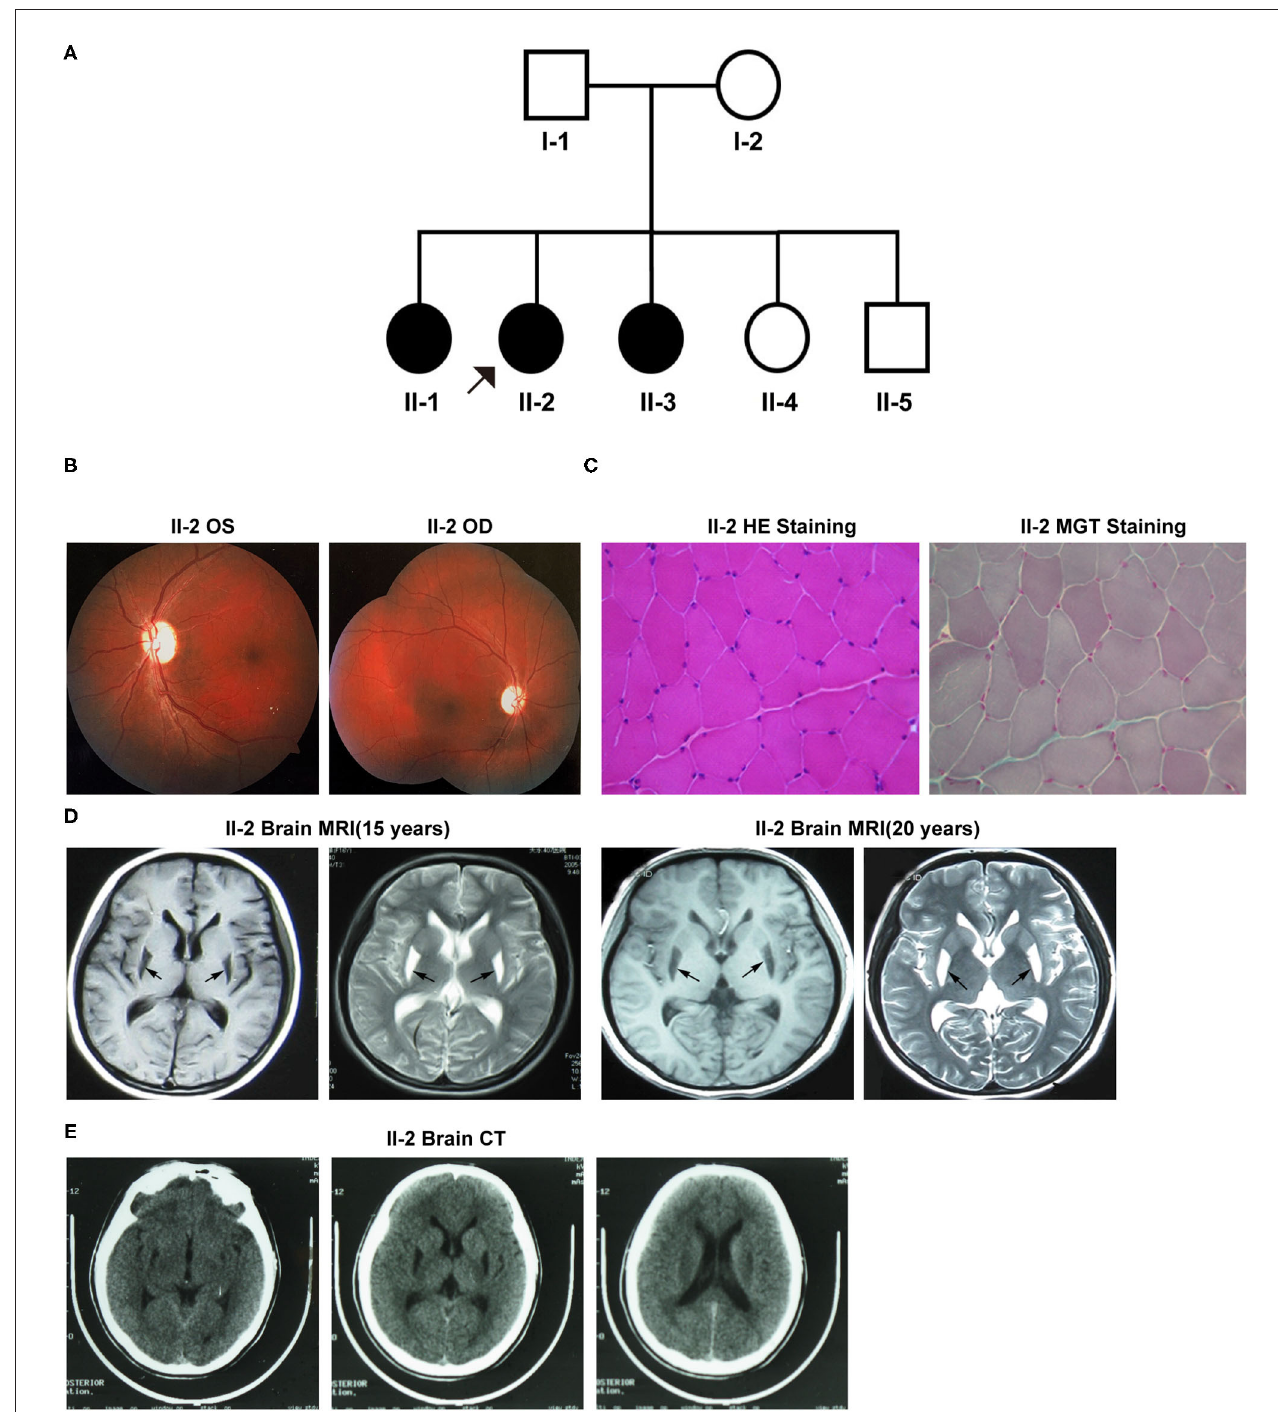
FIGURE 1 | (A) The pedigree diagram of the family included in this study. (B–E) Clinical manifestations of the proband (II-2). (B) Fundus fluorescein angiography. (C) Muscle biopsy with specific staining. (D) Brain MRI at 15 and 20 years old. (E) Brain CT. OS, oculus sinister; OD, oculus dextrus; HE, hematoxylin-eosin; MGT, modified Gömöri